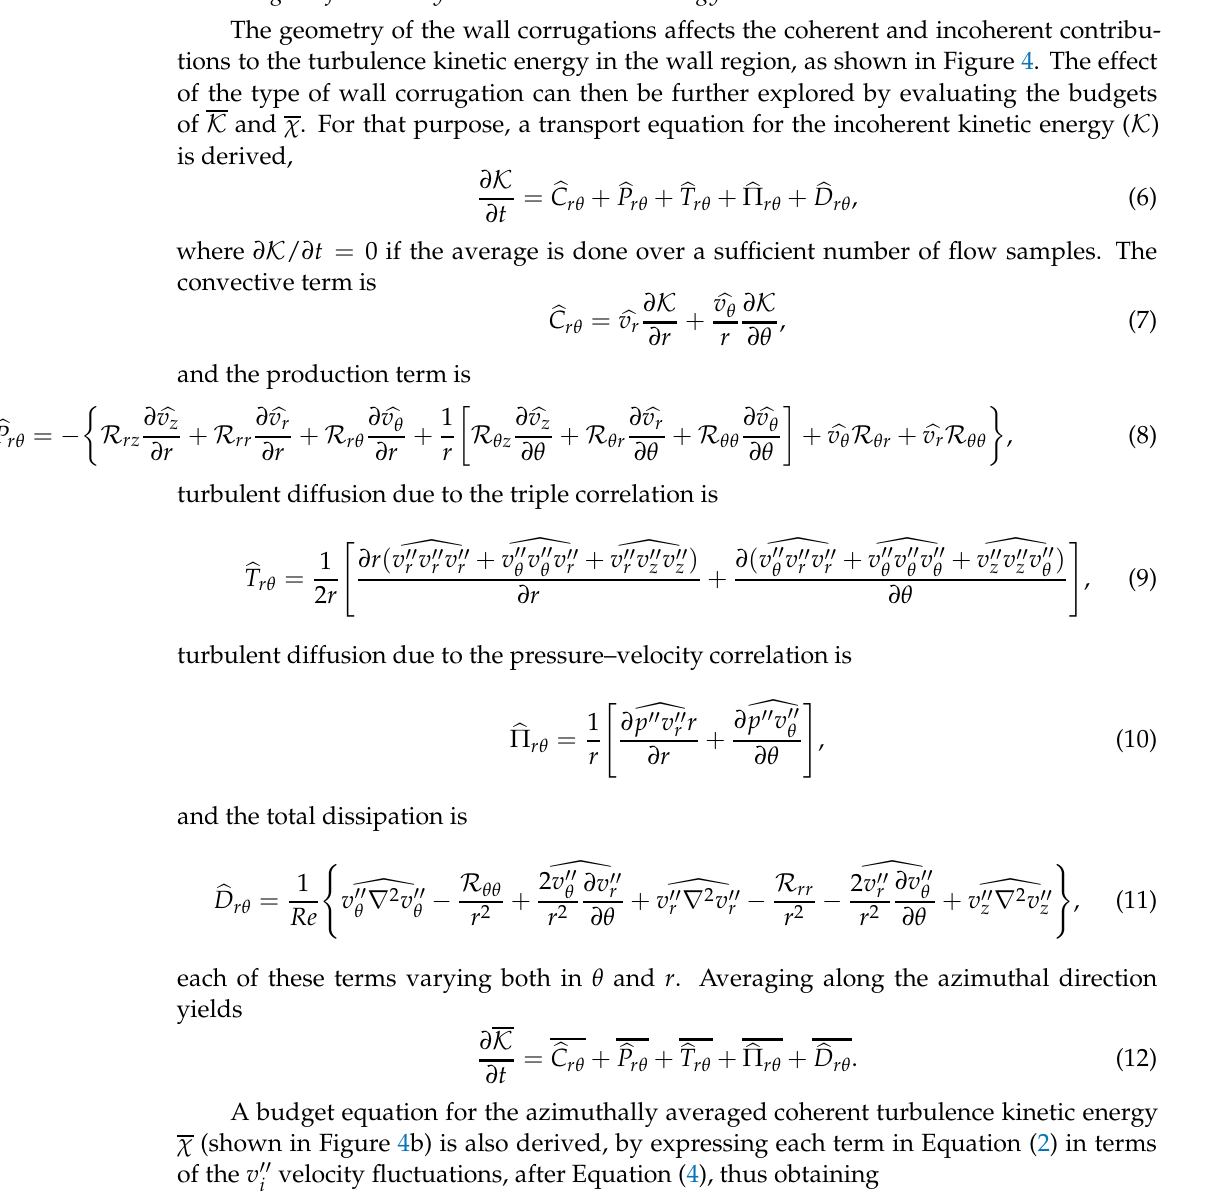
Figure 8. Contour plots of inner-scaled coherent wall-normal velocity fluctuations ( gular bars TLS : ( b ); rectangular bars SLL : ( c ); and staggered cubes CS : ( d ). Positive contours are in red, negative in blue, with increment ∆ + =